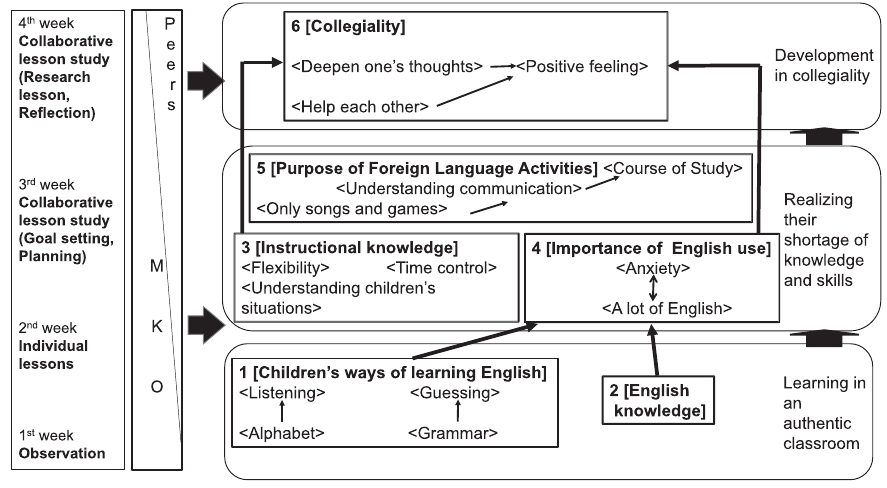
Figure1. Diagram showing relational core-categories, categories, and concepts